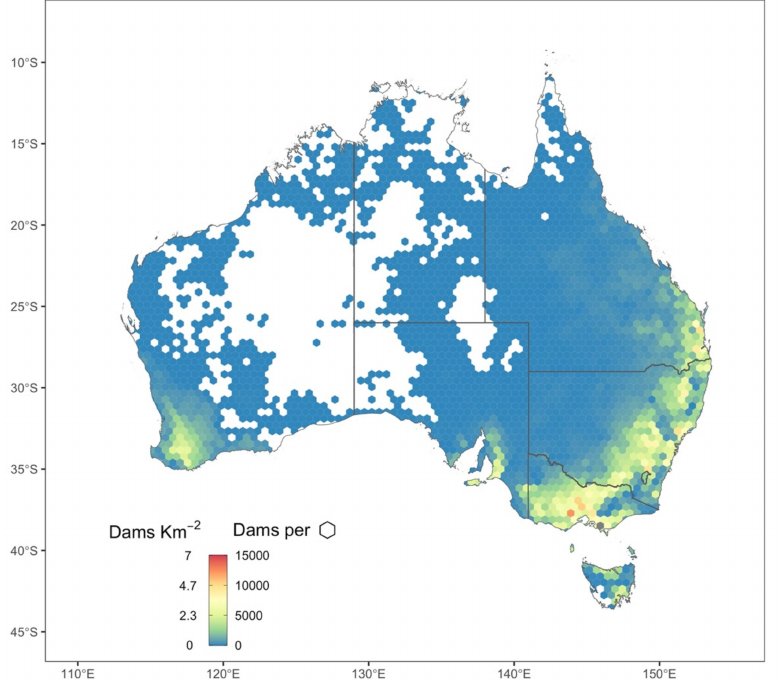
Figure 2. Distribution of documented dams in each Australian State and Territory, compiled from the maps in Table S1. The colour represents density (dams km − 2 ) and total counts (dams per hexagon), with empty hexagons indicating no reports of dams in the